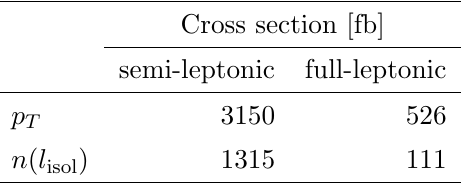
Table 2. Cross section of the background process (cid:22) ttjjjj at 100 TeV in fb. During event generation we require at least two quarks to be bottom or charm quarks with p T > 40 GeV. The other two quarks are required to be boosted with p T > 400 GeV. The resulting cross sections are given in the row labeled p T . Before the analysis we require the presence of at least one and two isolated leptons for semi- and full hadronic events, respectively. The isolation criterion is given at the end of section 3.1. We give the cross section after this pre-cut in the row labeled n ( l isol ). we have also assumed the top Yukawa coupling (cid:21) takes the value known from the SM, up t to corrections of order v 2 = m 2 T